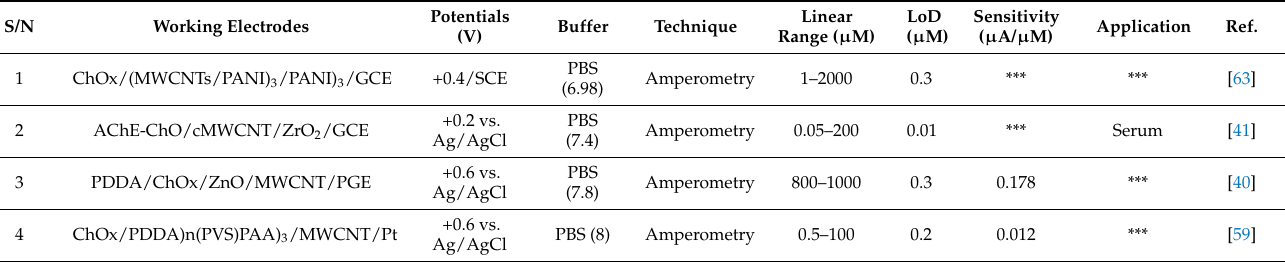
Table 1. Electrochemical choline biosensors.